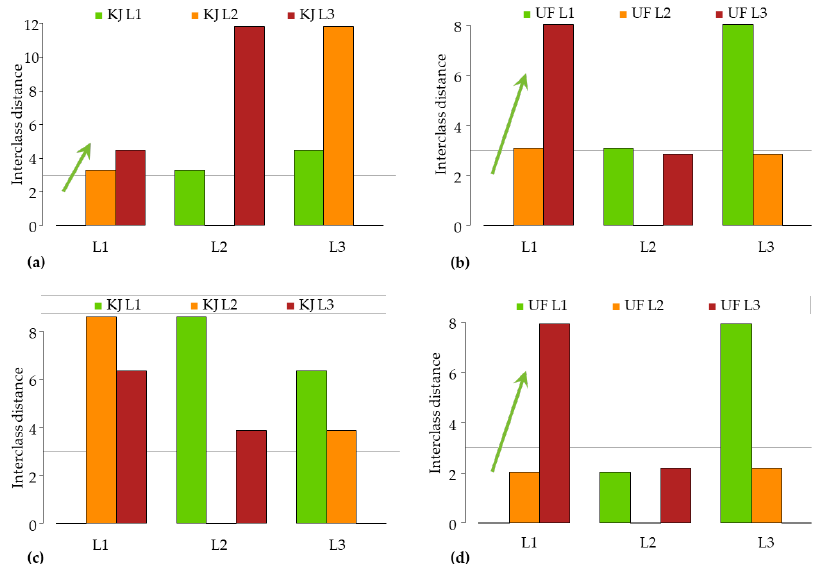
Figure 11. The SIMCA interclass distances according to ripeness: ( a ) results of ‘Kántorjánosi’ samples on day 1 ( n = 28, k = 2); ( b ) result s of ‘Újfehértói fürtös’ samples on day 1 ( n = 33, k = 1); ( c ) results of ‘Kántorjánosi’ samples on day 10 ( n = 33, k = 2); ( d ) results of ‘Újfehértói fürtös’ samples on day 10 ( n = 33, k = 2).